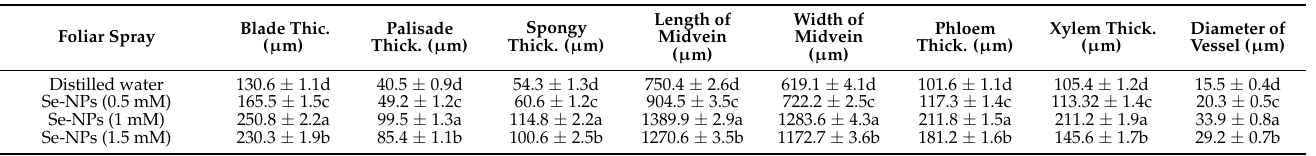
Data are means (n = 9) ± SE. In each column, means with different letters are considered significantly different at p ≤ 0.05. Thick.,